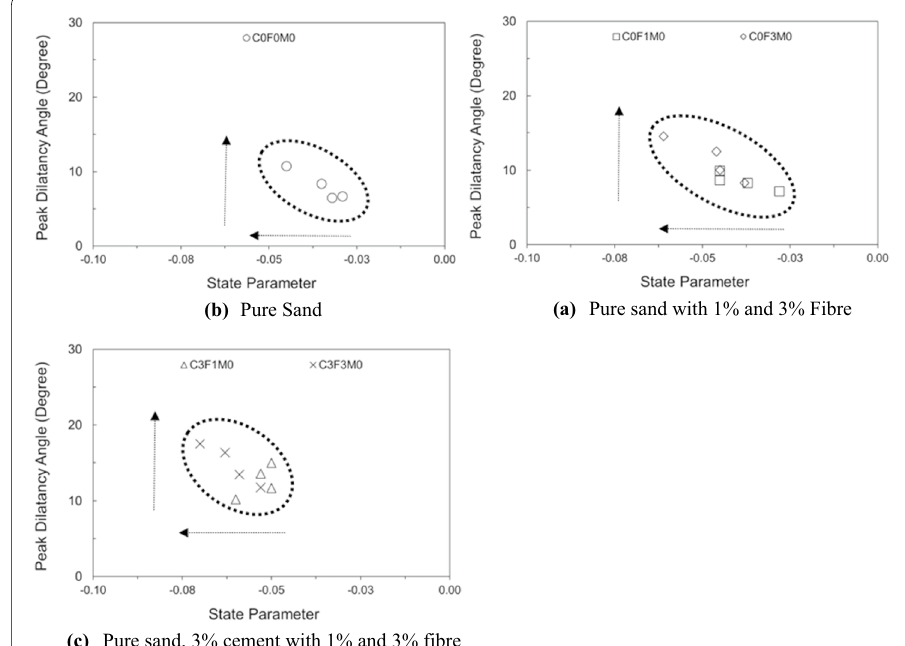
Fig. 8 Peak dilatancy angle vs. state parameter from CID tests for unreinforced, fibre, and fibre reinforced cemented Toyoura sand specimens a Pure sand with 1% and 3% fibre b Pure sand c Pure sand, 3% cement with 1% and 3% fibre